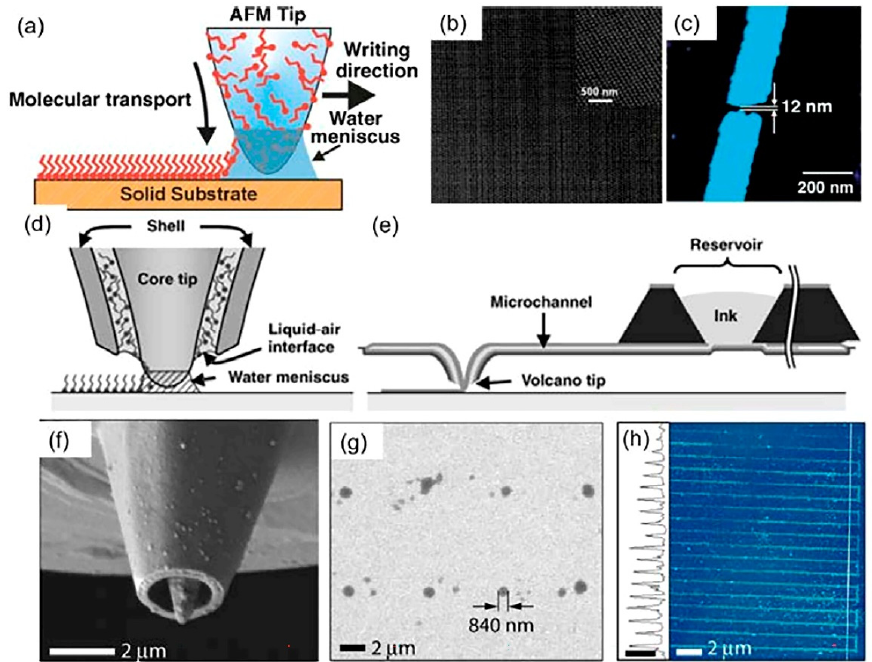
Figure 12. ( a ) Schematic representation of the dip pen nanolithography (DPN) process. A water meniscus forms in area between tip and substrate which facilitates a molecular transport from the tip to the target substrate; ( b ) Tapping mode AFM images of 60 nm Au nanodots deposited by DPN and subsequent etching; ( c ) 12 nm Au nanogap fabricated by DPN and subsequent etching; ( d ) Schematic representation of fountain pen nanolithography. The ink is dispensed through the hollow tip to the substrate; ( e ) Schematic representation of the nanofountain pen probe structure. A micro reservoir for storing inks is connected to the volcano tip through a microfluidic channel; ( f ) SEM image of the volcano tip; ( g ) SEM image of a 2 × 4 array of anti-BSA IgG dots patterned on a BSA substrate (46% RH) by fountain pen; ( h ) Tapping-mode AFM image and height profile of parallel lines of biotin-BSA patterned on 6-Mercaptohexanoic acid (MHA) at a translation rate of 80 µm/s (50% RH, height scale bar in profile is 20 nm). Reproduced from Ref. [174]. Copyright 2017, MDPI.